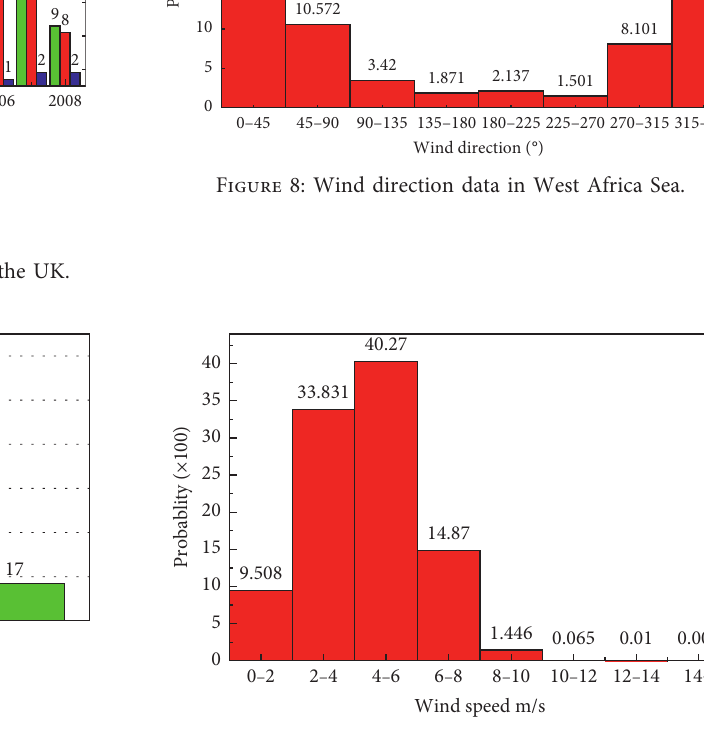
Figure 9: Wind speed data in West Africa